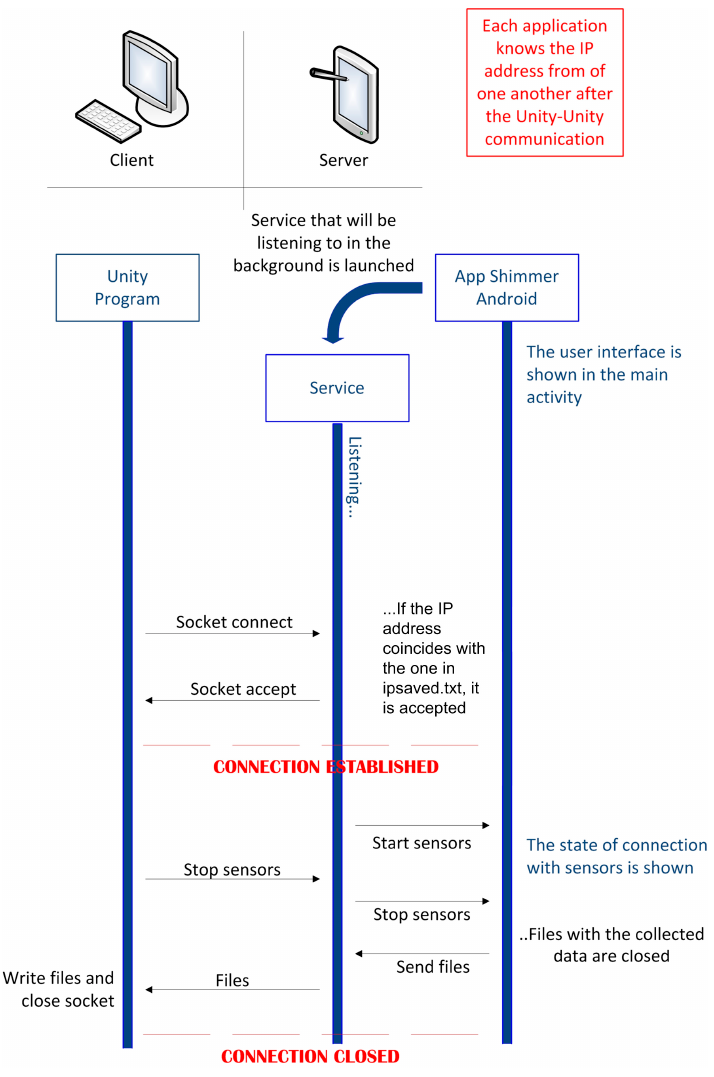
Figure 8. Unity-Android Communication.